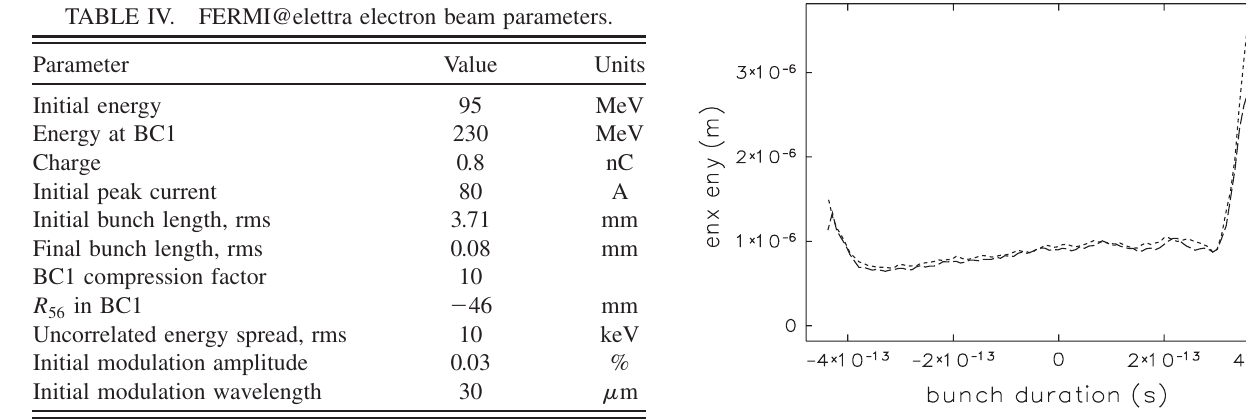
FIG. 3. Slice horizontal (short dashed line) and vertical (long dashed line) normalized emittance at the linac end after single compression in BC1 by a factor 10; the bunch head is for negative time coordinates. The projected normalized horizontal emittance for 60% of the particles in the transverse phase space is 0.8 mm mrad.